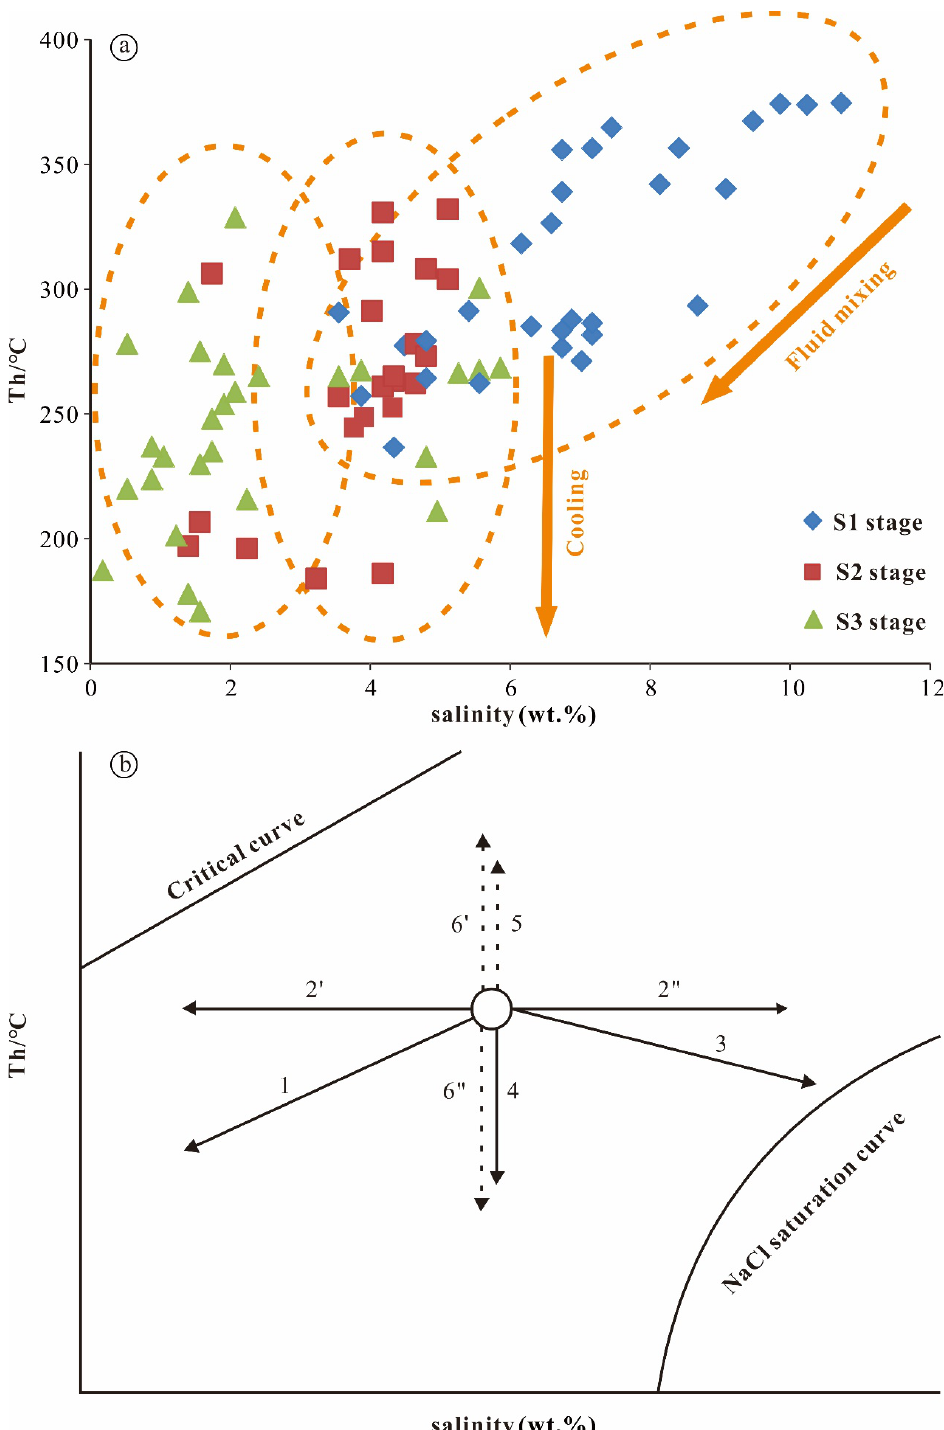
Figure 14. ( a ) Homogenization temperature vs. salinity plots of fluid inclusions in quartz from the Hongqiling deposit; ( b ) various fluid evolution trends in the Th-salinity bivariate plot. Trend 1 indicates that the original fluid is mixed with the cooler and lower salinity fluid; trends 2′ and 2′ ’ represent the results of isothermal mixing of fluids with different salinity; trend 3 shows that the boiling of fluid leads to the increase in salinity of residual liquid phase; trend 4 represents pure cooling of fluid; trend 5 represents the leakage of inclusions during heating; trend 6 shows the necking phenomenon of inclusions